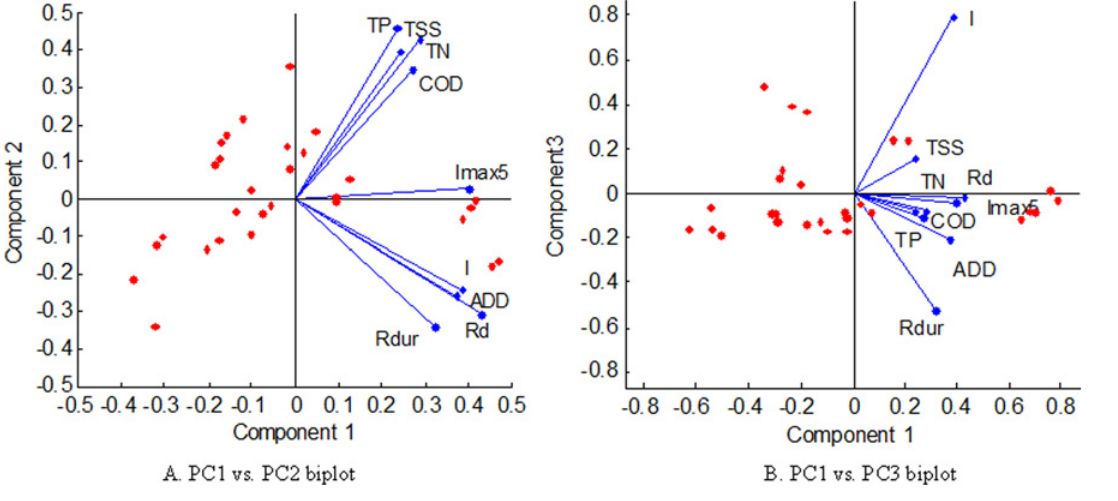
Fig 5. PCA biplots for the FF 40